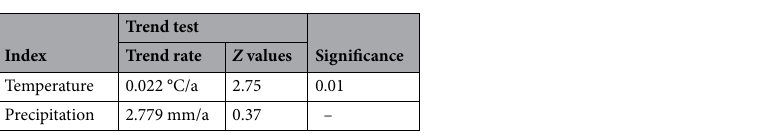
Table 1. Trend analysis of annual precipitation and temperature using the M–K test in the SRB.